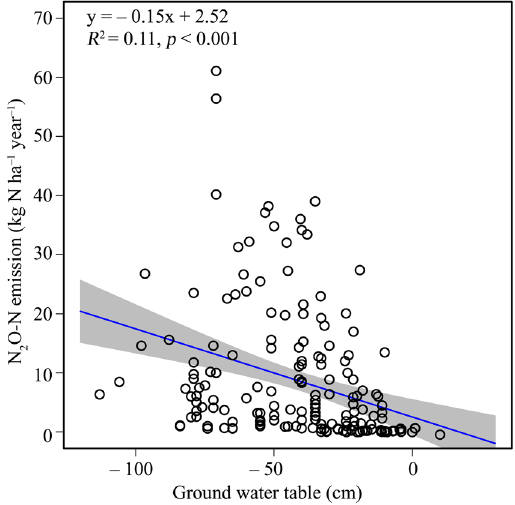
Fig. 3 Scatter plot of annual nitrous oxide (N 2 O-N) emissions from peatlands against the annual groundwater table. The data are from Liu et al. 30 and Höper et al. 43